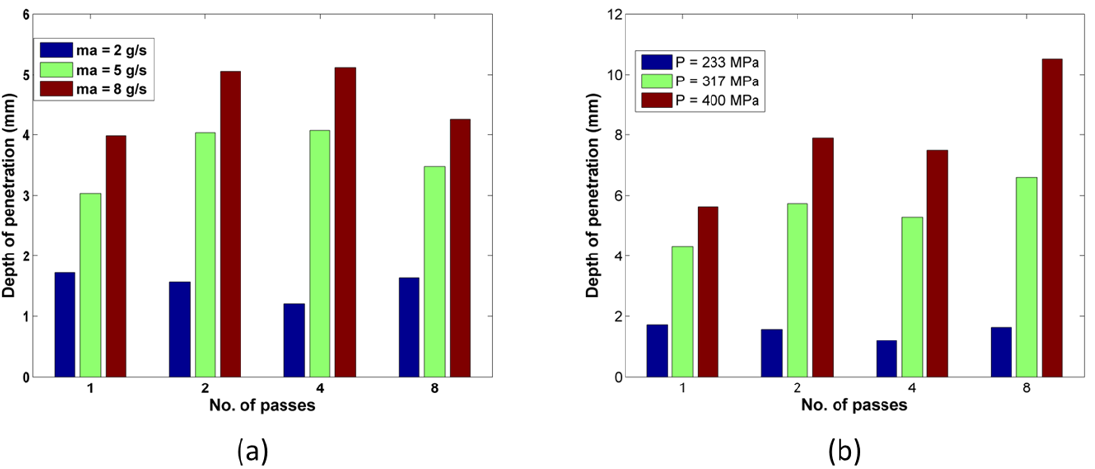
Figure 6. Variation of depth of penetration for cases with different number of passes under different ( a ) abrasive mass flow rate values and ( b ) jet pressure values.